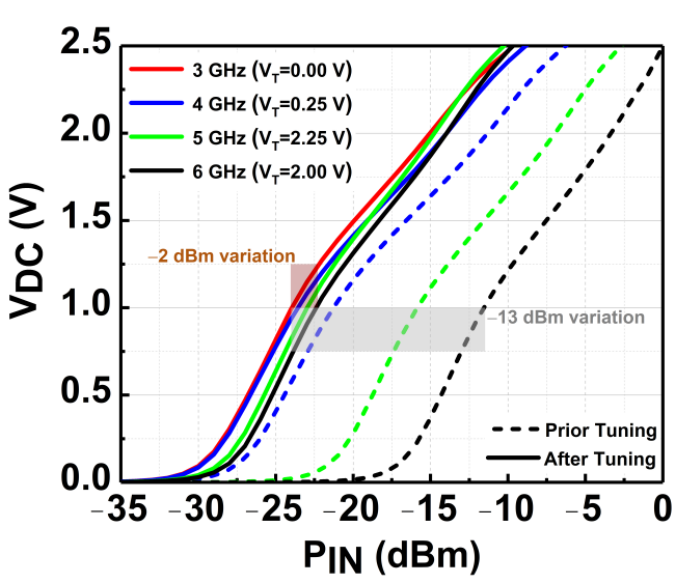
Figure 16. Simulated V DC of the CCDD-TVB rectifier across frequency before and after tuning.